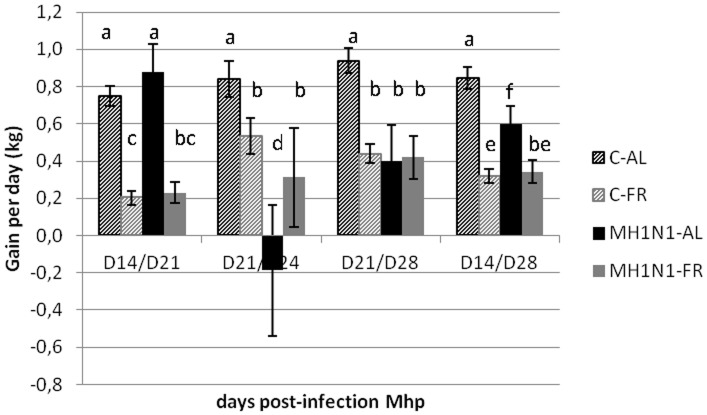
Mean daily weight gain (kg) of pigs after Mhp and H1N1 inoculations.Mean daily weight gains between Day (D) 14 and D21 (the week before H1N1 infection), between D21 and D24 (between 0 and 3 DPI H1N1), between D21 and D28 (between 0 and 7 DPI H1N1) and between D14 and D28, for control (C) or co-infected (MH1N1) groups fed ad libitum (AL) or feed restricted (FR): C-AL (hatched black), C-FR (hatched gray), MH1N1-AL (black) and MH1N1-FR (gray) groups. Mean daily weight gains with different letters are significantly different with P<0.05.